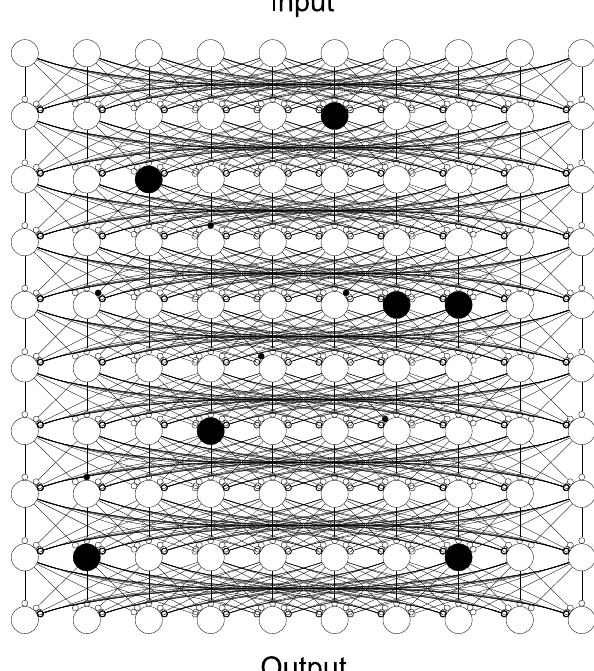
Figure 2. Causal fields. Distributed causality is elegantly illustrated by the behaviour of artificial neural networks trained to transform an input into an output by optimising the weights of a stack of fully connected nodes. Here the input-output transformation is causally dependent on the nodes and their connections, for it cannot occur without most of them. But when the network is large, its dependence on any limited subset of nodes will be low. This is not because there is a reserve of unused nodes, but because the causality of the system is constitutionally distributed. Inactivating (in black) a set of nodes (large circles) or their connections (small circles) will thus degrade performance broadly in proportion to their number and not necessarily their identity. Causality thus becomes irreducible to any simple specification of necessity and sufficiency. Instead, each node becomes an insufficient but necessary part of an unnecessary but sufficient set of factors: an INUS condition. An adequate description of the causality of the system as a whole then requires specification of the entire causal field of factors: no subset will do, and no strong ranking need exist between them. If the architecture of real neural networks makes such causality possible—and it certainly does—we need to be capable of modelling it. But this is more than just a theoretical possibility. It is striking that encouraging distributed causal architectures through dropping nodes or connections during training dramatically improves the performance of artificial neural networks. And, of course, real neural substrates often exhibit remarkable robustness to injury, a phenomenon conventionally construed as “reserve”, but since no part of the brain lies in wait, inactive, distributed causality is a more plausible